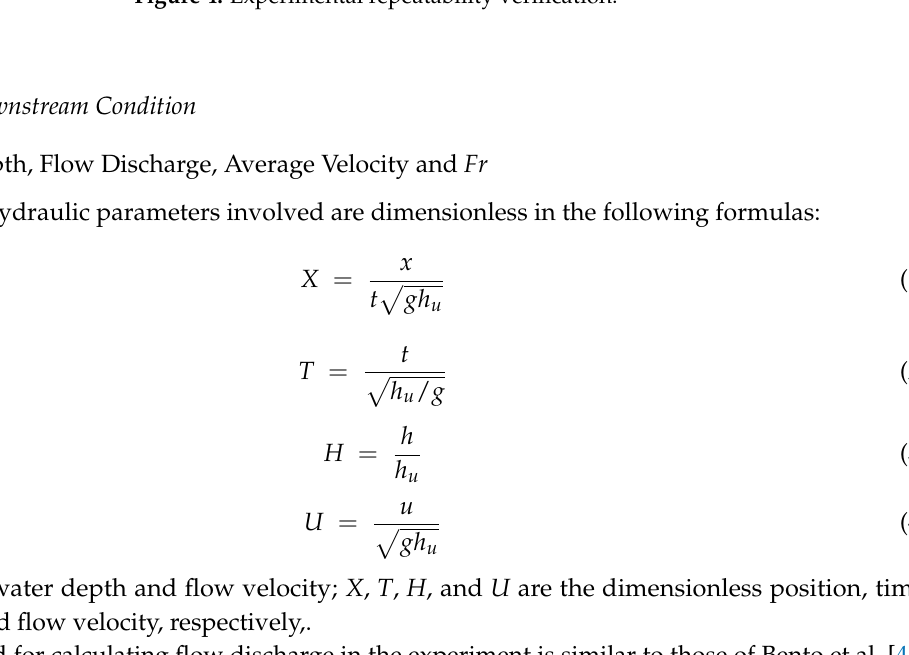
Figure 4. Experimental repeatability verification.